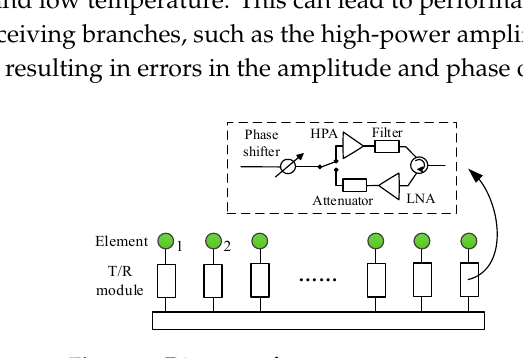
Figure 2. Diagram of antenna array structure.